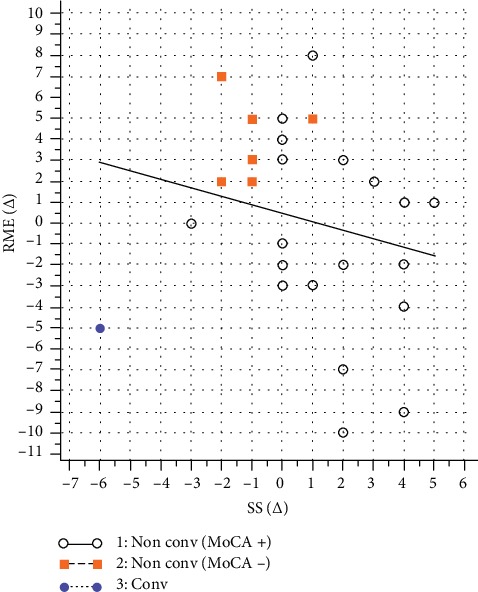
Partial correlation analysis between changes (delta score T2 vs. T0) of RME test and SS task in aMCI sample. Non conv = non converter; Conv = converter; MoCA+ = MoCA delta score T2 vs. T0 ≥ 0; MoCA- = MoCA delta score T2 vs. T0 < 0.